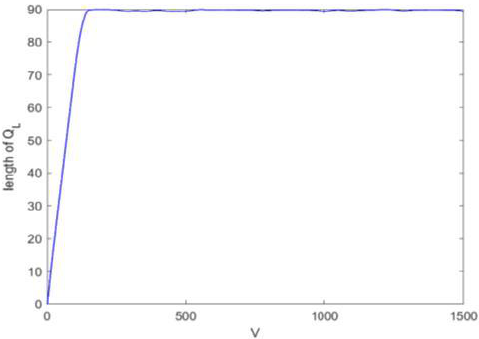
Figure 4. Curve of high-priority queue length changing with weight.